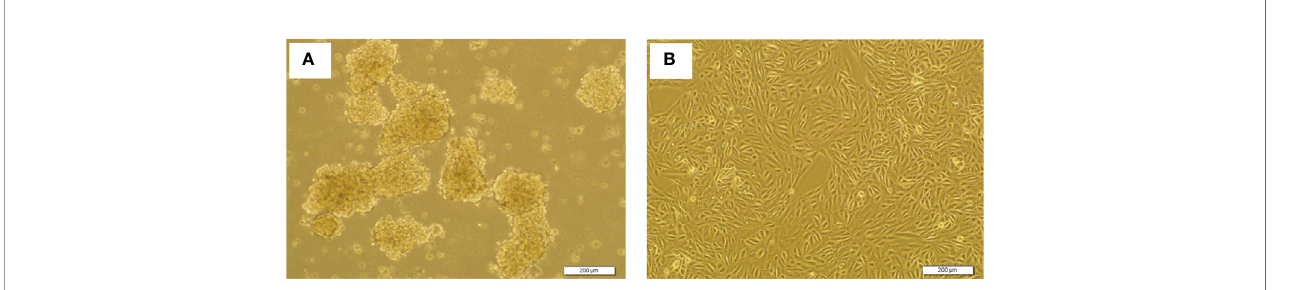
FIGURE 3 | Sphere formation by ACHN cells. Sphere Formation by ACHN Cells. (A) Spheroid derived cells (SDCs) from parental ACHN cells (PCs) cultured anchorage-independent conditions formed typical spheroids in the presence of growth factors at the second passage. (B) ACHN adherent monolayer cells. Figures are shown with a magni fi cation of 100 X.